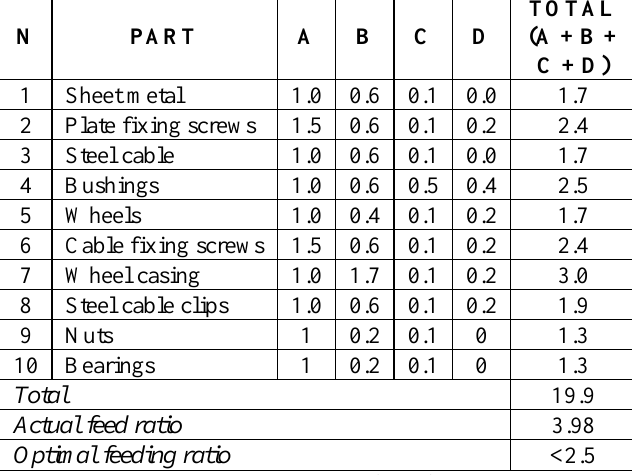
Table 2: Result of landing gear handling analysis.